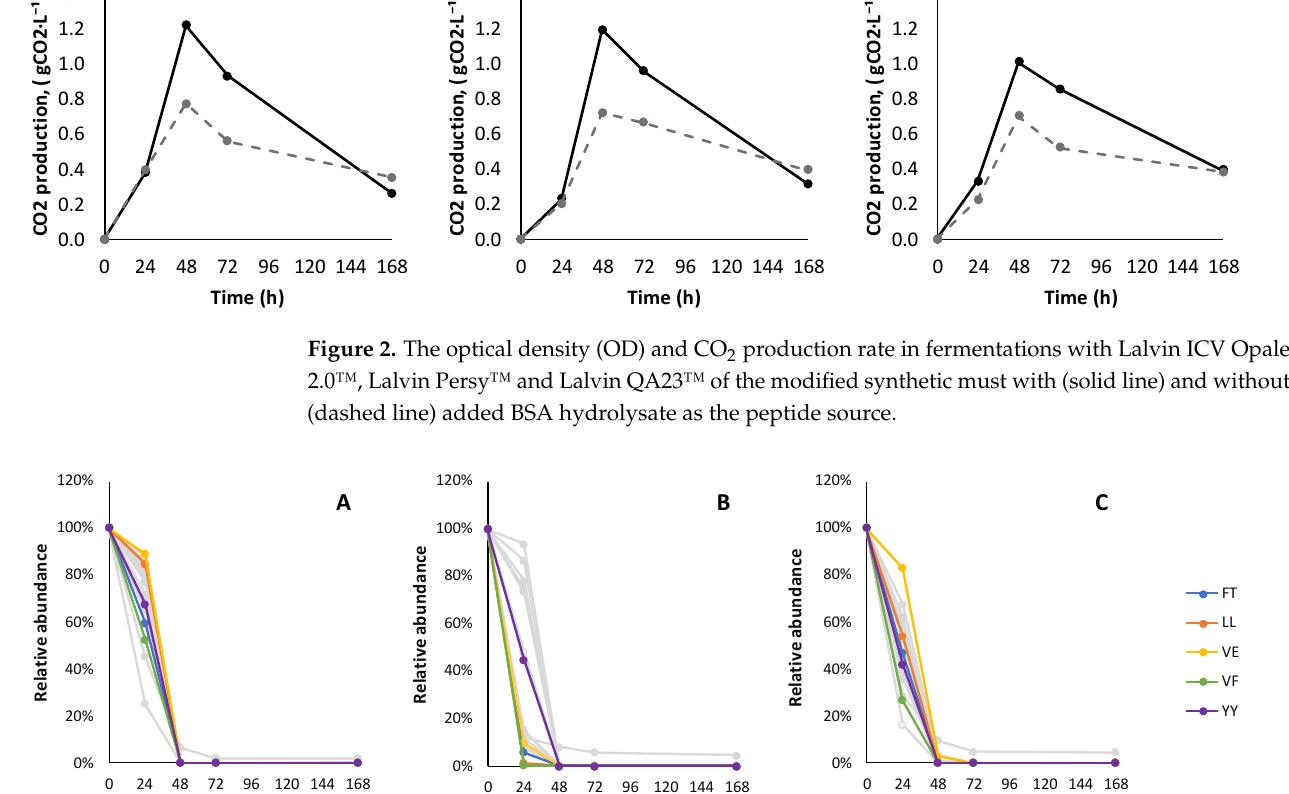
Figure 3. The relative consumption trends of 19 dipeptides in fermentation with Lalvin ICV Opale 2.0™ ( A ), Lalvin Persy™ ( B ) and Lalvin QA23™ ( C ) of the modified synthetic must with added BSA hydrolysate as the peptide source. The five dipeptide candidates with the highest abundance are shown in colour. Other dipeptide candidate sequences and their observed relative consumption trends are shown in Table A4.